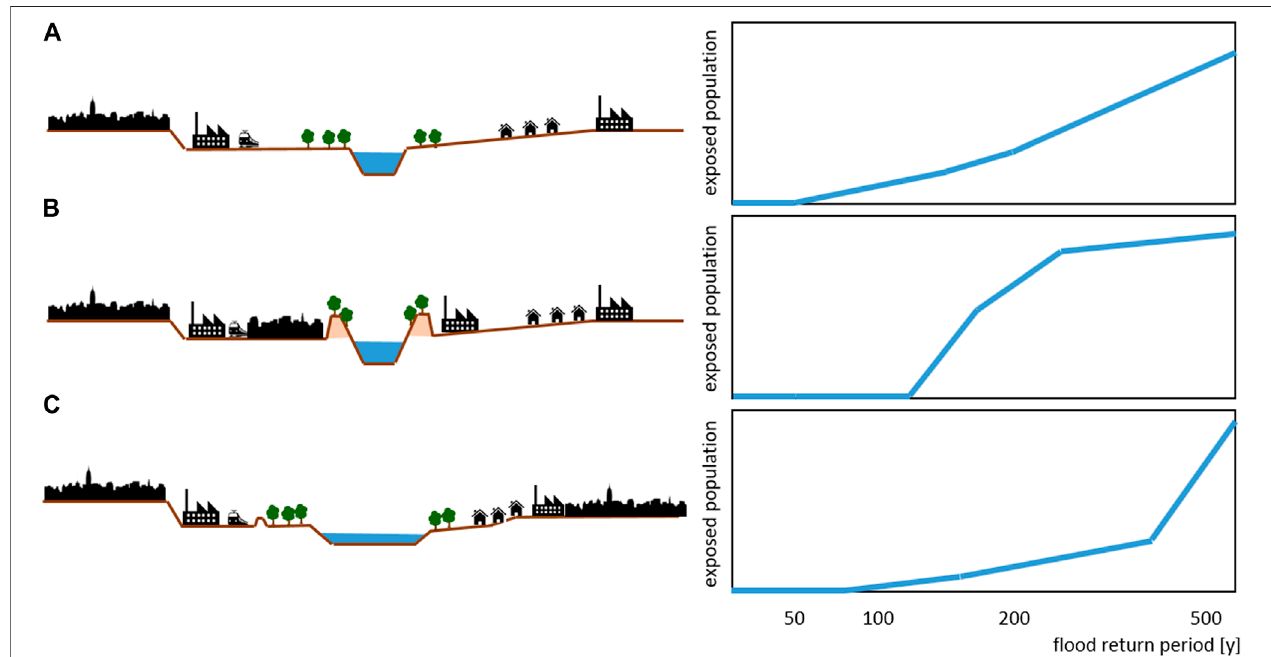
FIGURE 2 | Schema of different characteristics of the exposure footprint of the fl oodplain. (A) A nearly linear increase in the exposed population with increasing fl ood magnitude. (B) Aconcaveshape, meaningthatexposureincreases sharplyfollowinglevee overtopping. This fl oodplain issensitivetochangesin fl oodswith return periodsaroundthestandardofprotection. (C) Arelativelyrobustbehaviortochangesinlower fl oodmagnitudes.This fl oodplainismostlysensitiveto fl oodmagnitudesin the upper